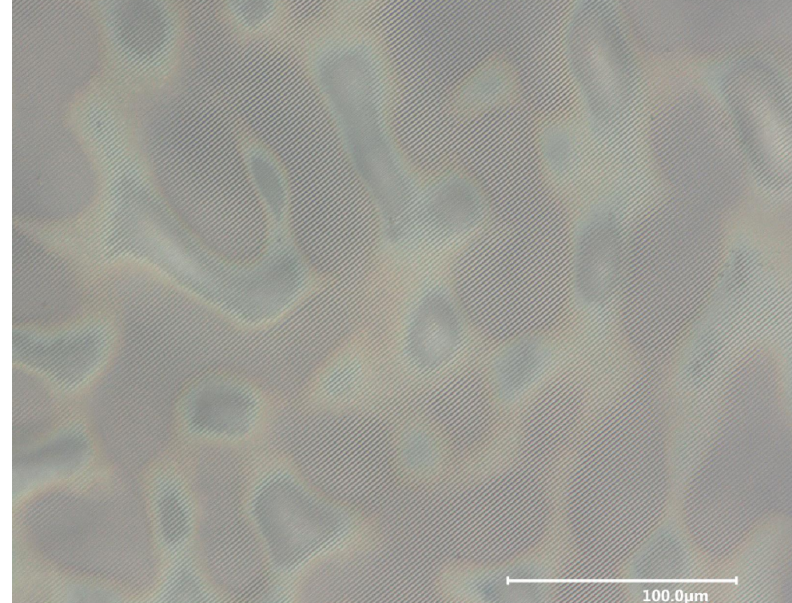
Figure 5. Optical micrograph of the grating on top of the diffusor structure. The lines and spaces follow the topography of the surface.